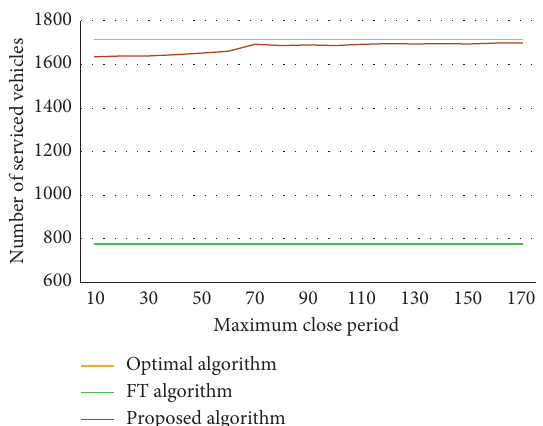
Figure 19: Effect of changing the maximum close period on the number of serviced vehicles using the OA, FT, and PA algorithms.